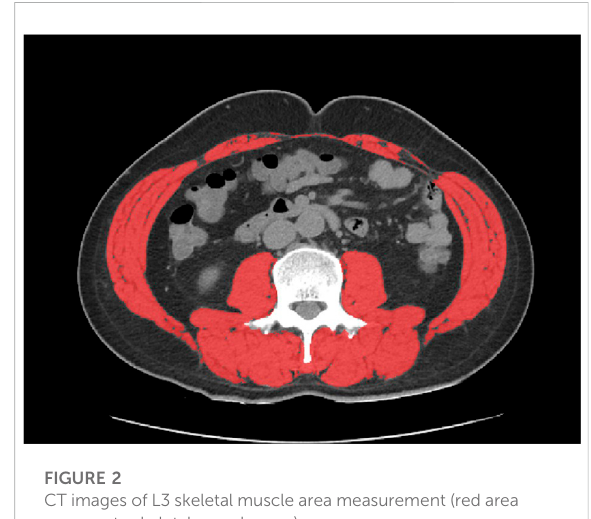
FIGURE 1 Study fl ow diagram of participant enrolment.